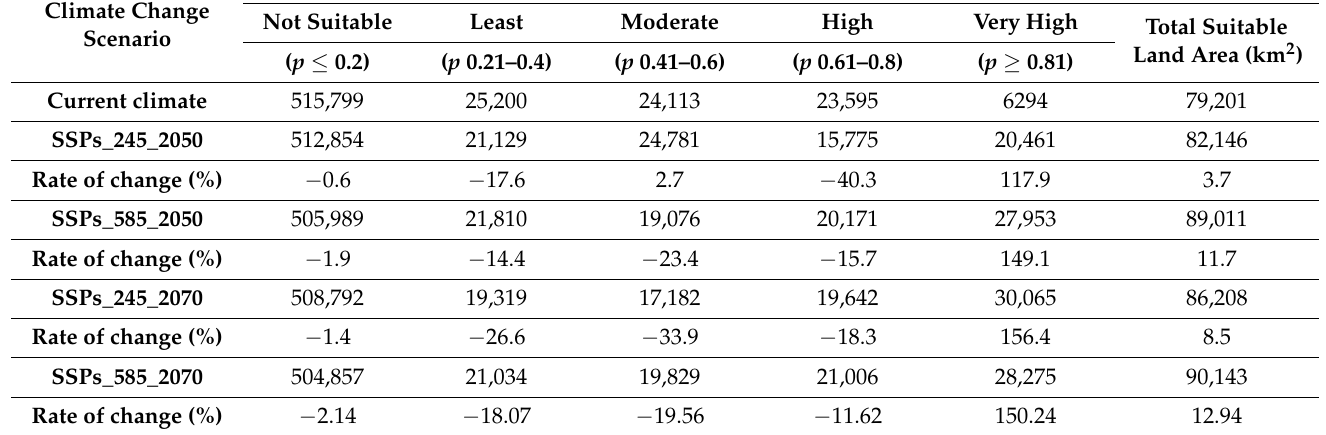
Table 2. The predicted probability of habitat suitability of the Himalayan goral under different climate change